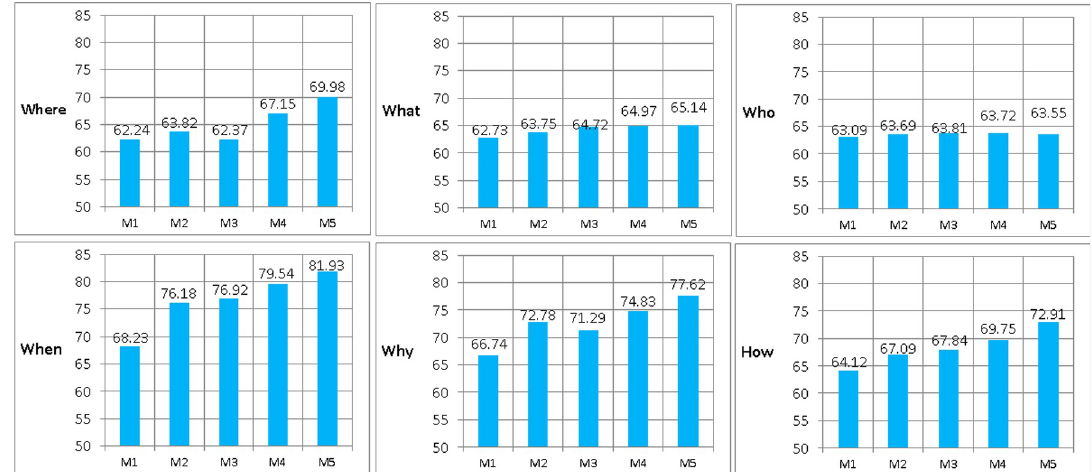
Fig 5. Performance of all the tasks on TVQA dataset by question type. M1-M5 represent Two-stream, PAMN, Multi-task, STAGE, and MAF-HMS, respectively.